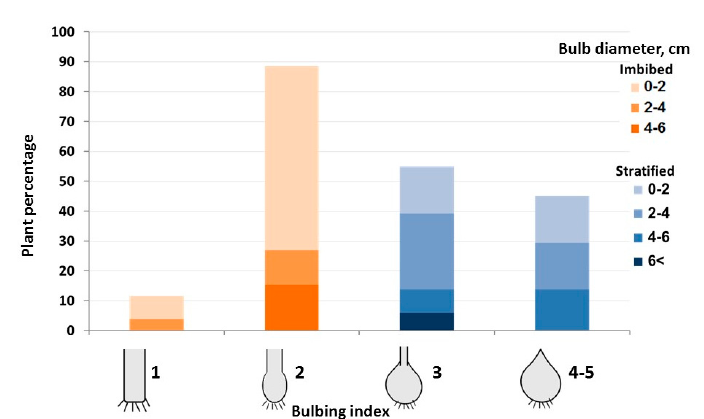
Figure 4. Effect of seed imbibition and stratification on bulbing index (BI) and bulb size in garlic hybrid 96 × 87. Sown November 2016, harvested June 2017. Orange columns represent plants raised from imbibed seed. Blue columns represent bulbs obtained from stratified seeds. n = 200.